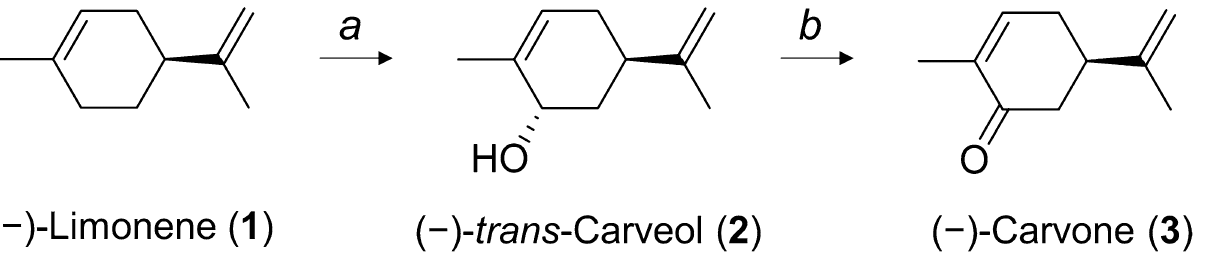
Figure 1. Biosynthesis pathway of carvone from limonene in Mentha sp . Biosynthesis pathway of (−)-carvone from the primary precursor (−)-limonene. The indicated enzymes are ( a ) cytochrome P450 limonene-6- hydroxylase and ( b ) carveol